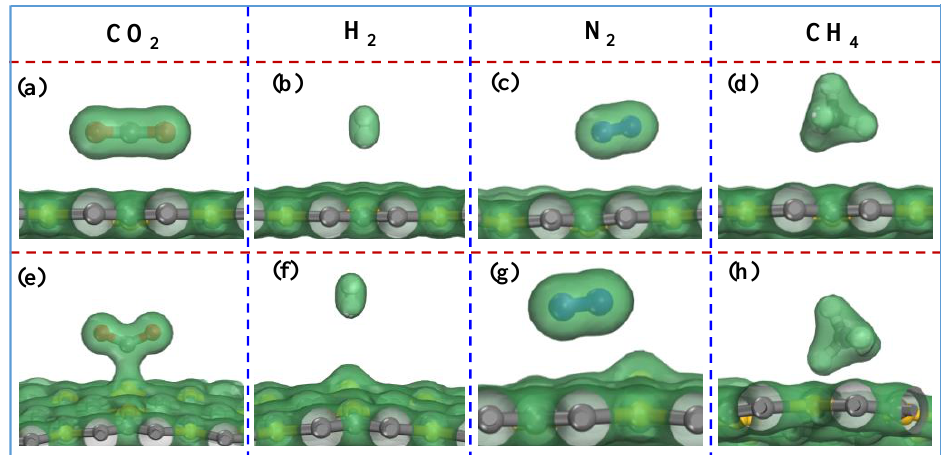
Figure 4. The electron density distribution of the most stable adsorption configurations of gas molecule (i.e., CO 2 , H 2 , N 2 and CH 4 ) adsorbed on the SiC 3 nanosheet. ( a – d ) Without the injecting negative charges, and ( e – h ) after the injection of negative charges with density of 1.23 × 10 14 e − /cm 2 .